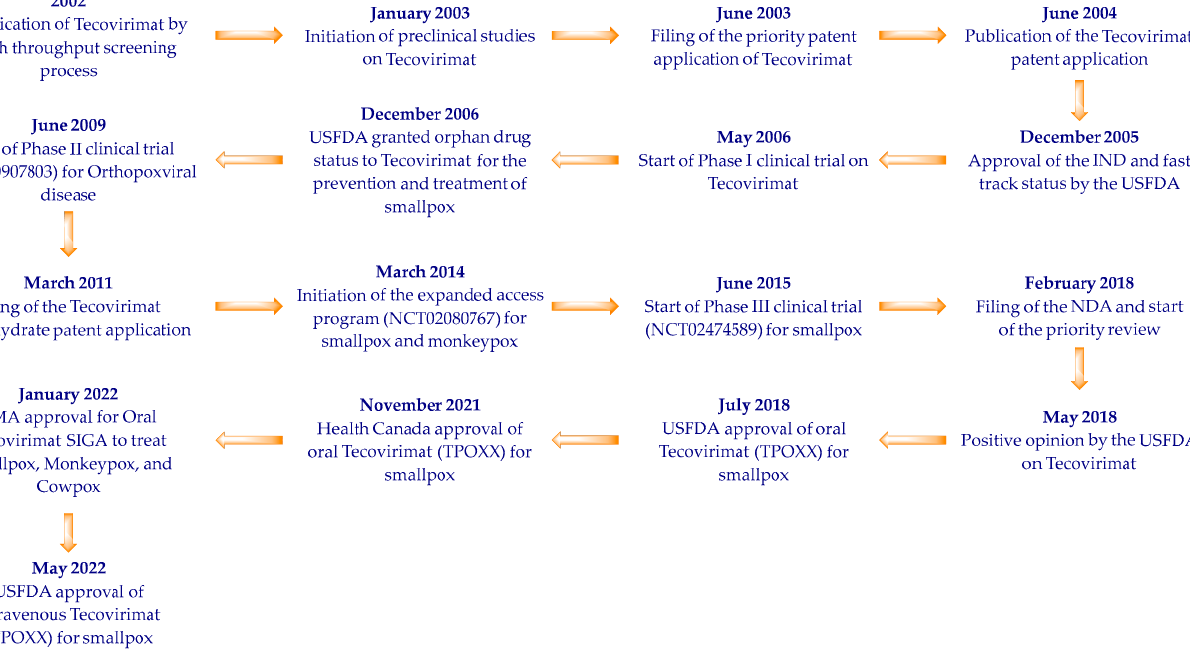
Figure 2. The development timeline of Tecovirimat.